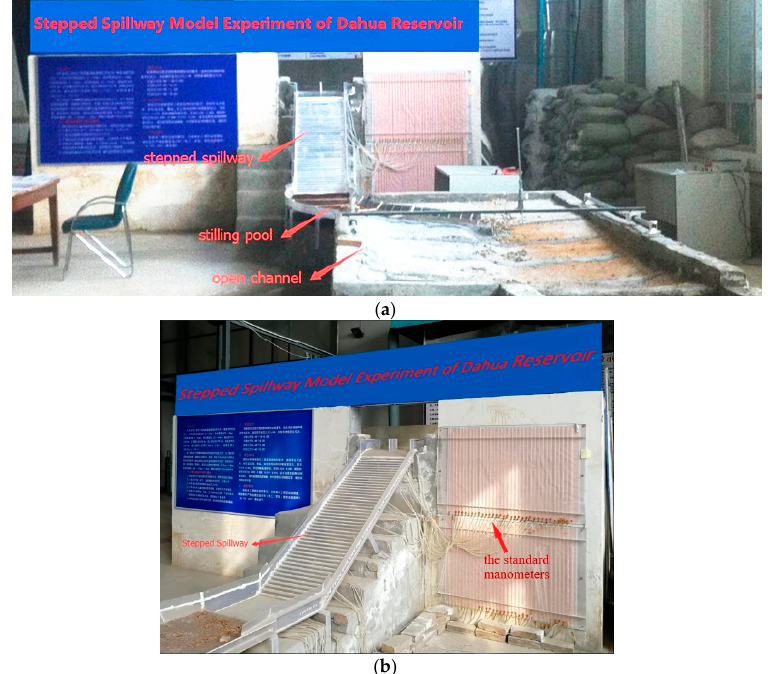
Figure 2. Site photo of laboratory spillway experiment: ( a ) Global view of facility; ( b ) Enlarged view of spillway with pressure measurement.